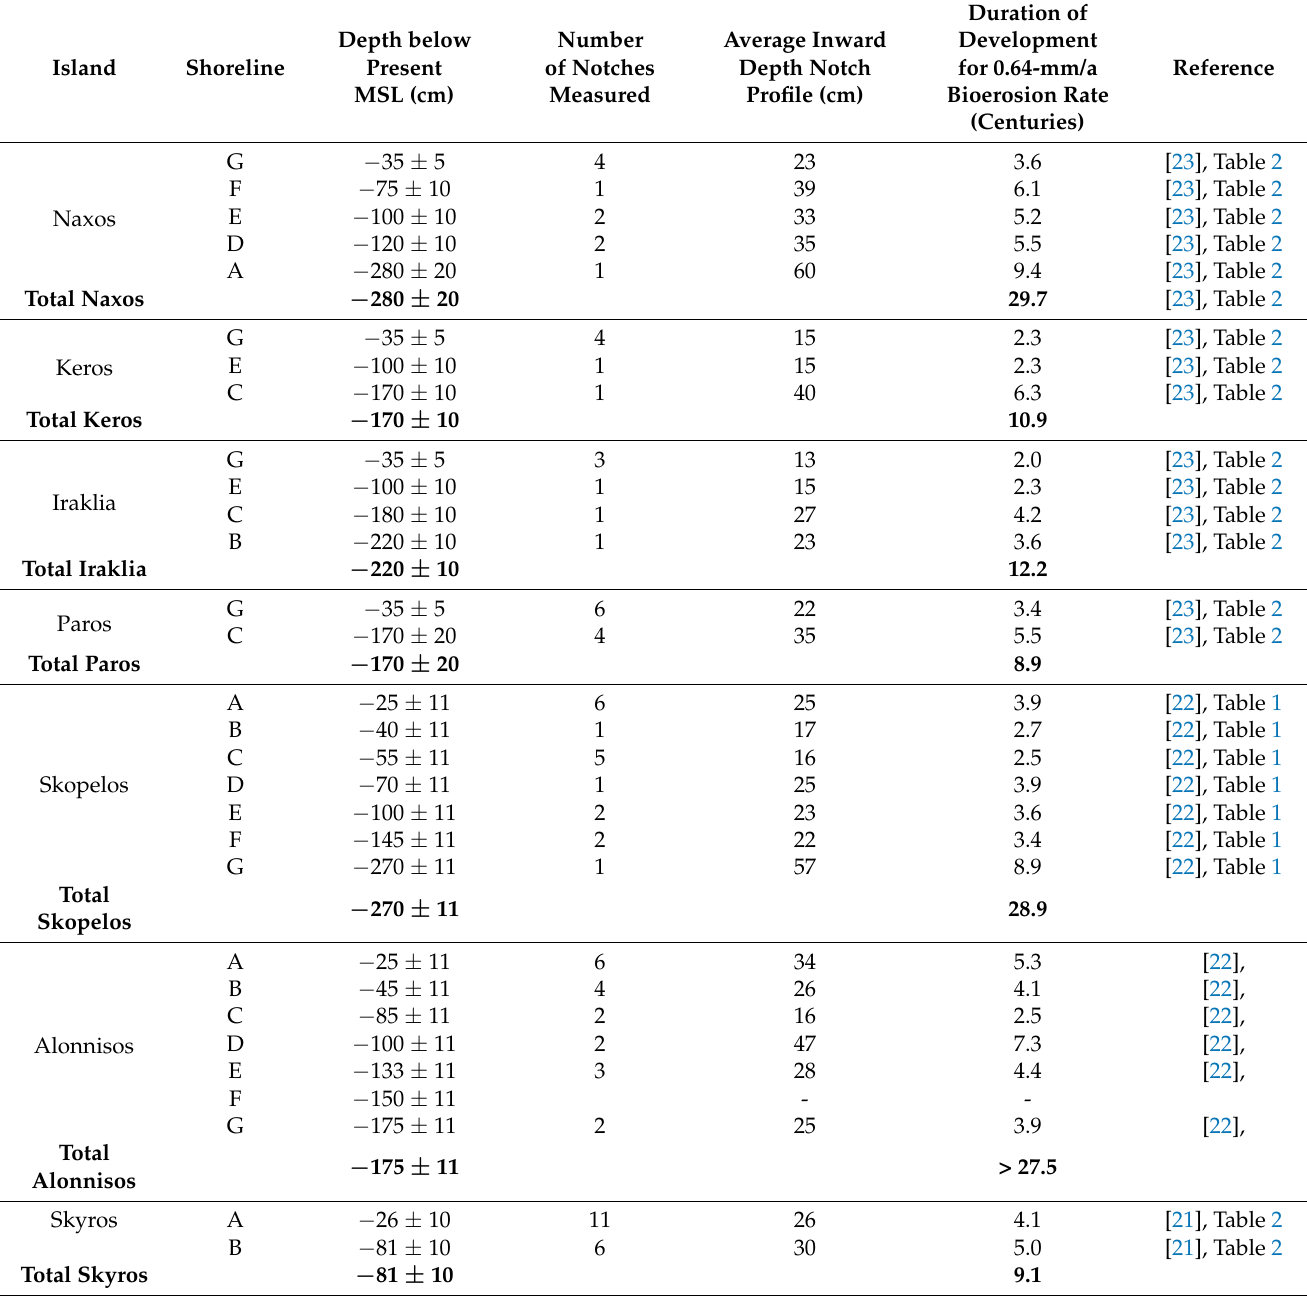
0.64 mm/a varied from three centuries at Iraklia to about four-and-a-half centuries at Paros. These estimations are consistent with a study by Vamvakaris et al. [54], who suggested very long return periods (> 200 years) for the broader Cyclades plateau for shallow earthquakes with M > 6.0. Table 2. Depth, number of tidal notches measured for each shoreline and possible duration of development of the submerged tidal notches in the islands of Naxos, Keros, Iraklia, Paros, Skopelos, Alonnisos and Skyros. Duration of Development Average Inward Number Depth below Reference for 0.64-mm/a Depth Notch of Notches Island Shoreline Present Bioerosion Rate Profile (cm) Measured MSL (cm) (Centuries)